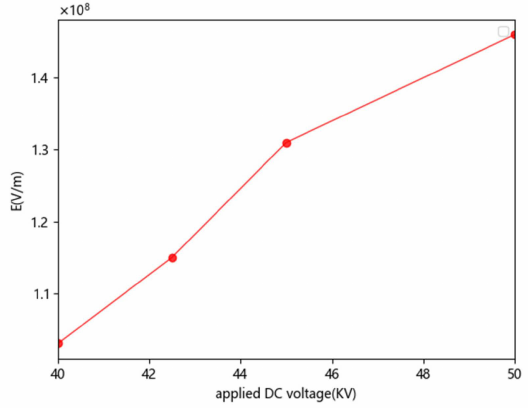
Figure 9. Variation of electric field strength with applied DC